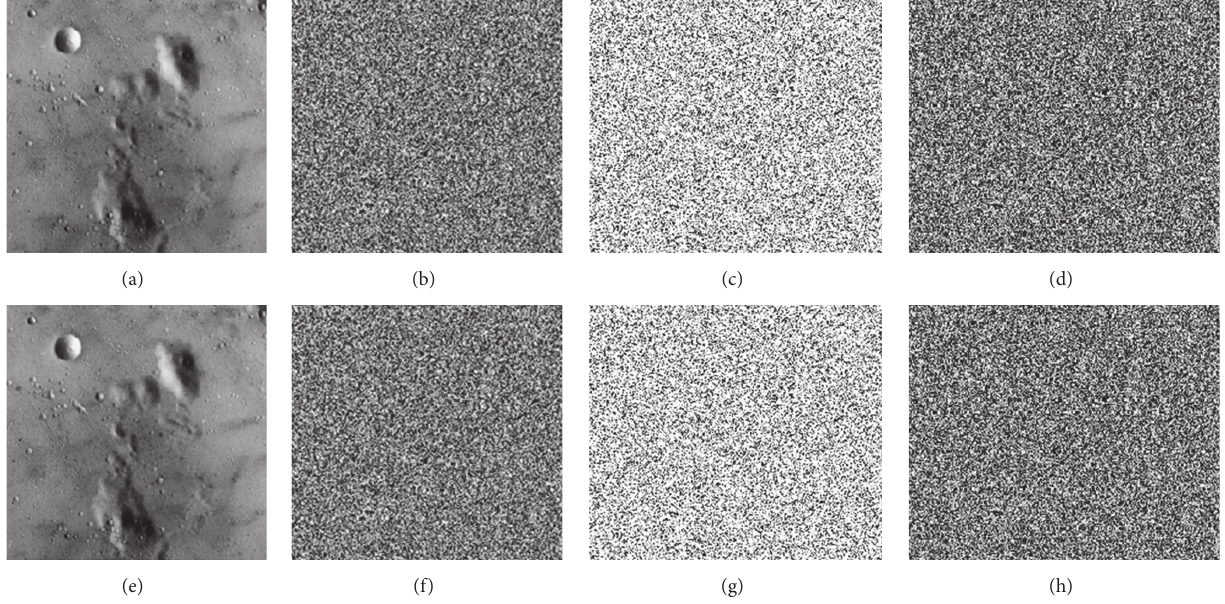
Figure 5: Key space analysis: (a) input plain image ( 𝑃 ); (b) encrypted image 𝐸 1 = Enc (𝑃,𝐾 1 ) ; (c) encrypted image 𝐸 2 = Enc (𝑃,𝐾 2 ); (d) difference of encrypted image: 𝐸 1 − 𝐸 2 ; (e) decrypted image 𝐷 1 = Dec (𝐸 1 , 𝐾 1 ) ; (f) decrypted image 𝐷 2 = Dec (𝐸 1 ,𝐾 2 ) ; (g) decrypted image = Dec (𝐸 ,𝐾 3 ) ; (h) difference of decrypted image: 𝐸 𝐷 3 1